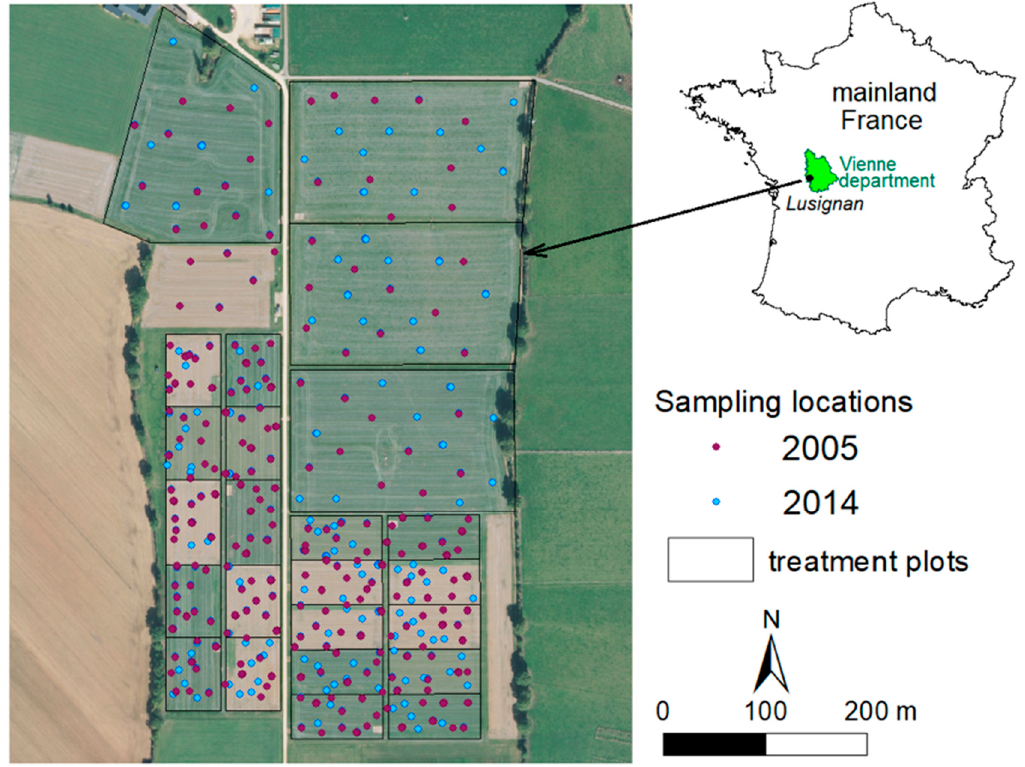
Figure 1. Map of the sampling plots in 2005 and 2014 over 20 cm-color orthophotograph from the French National Institute of Geographic and Forest Information (IGN, 2017).